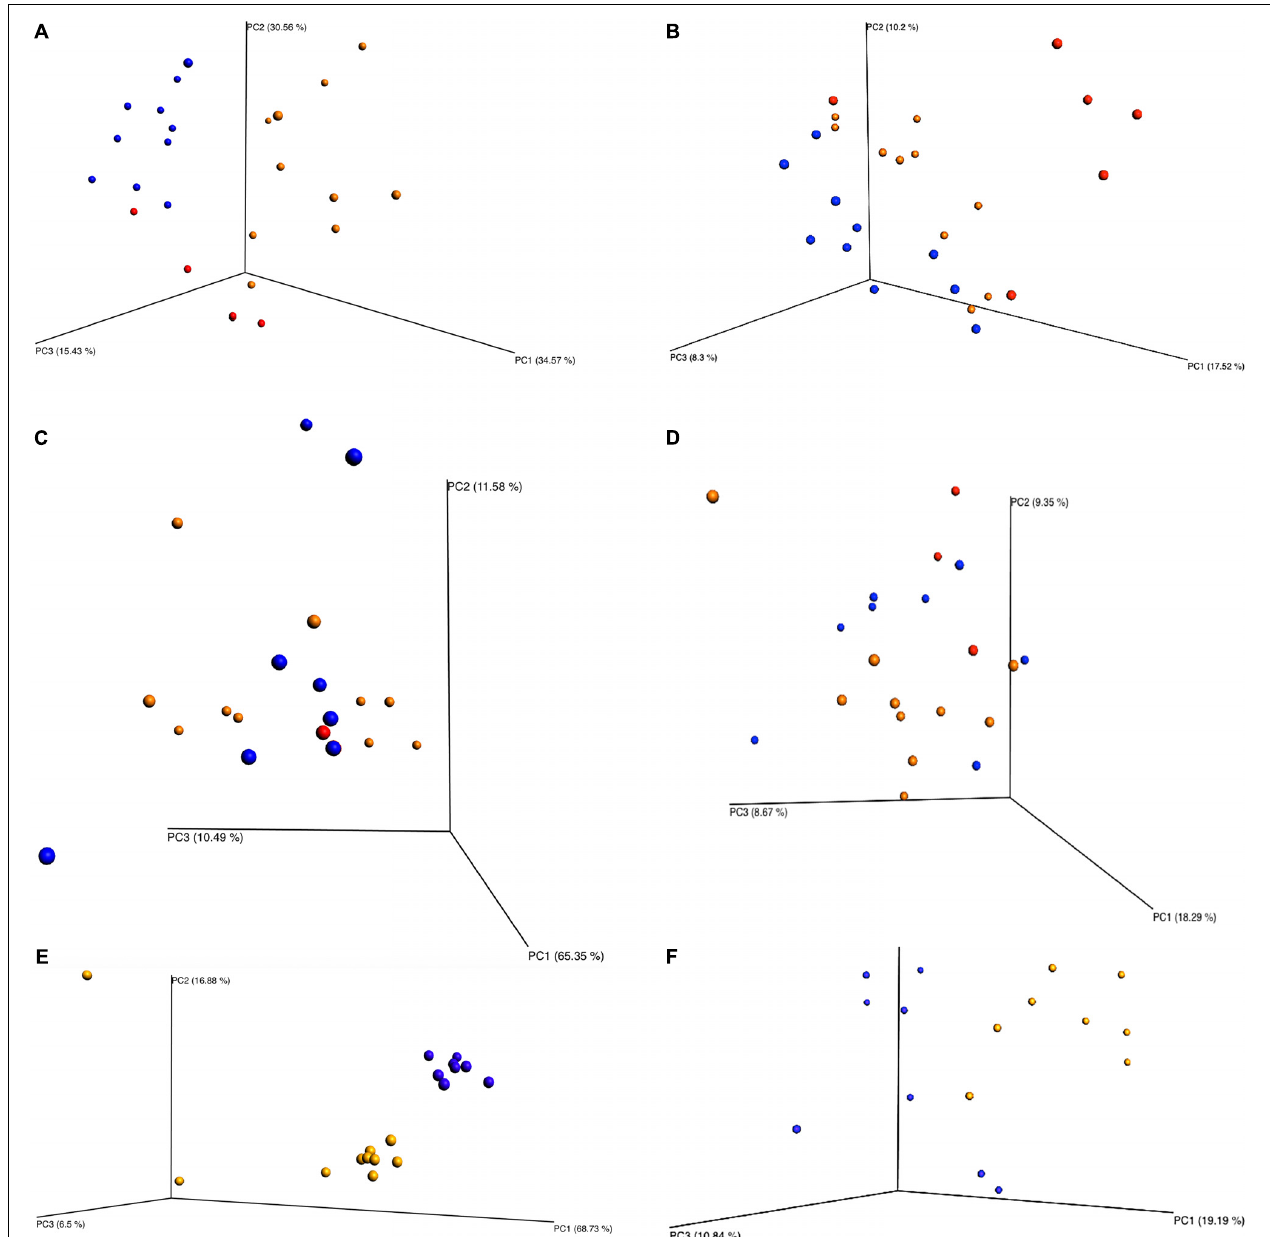
FIGURE 7 | Beta diversity between sampling locations and individual processing abattoir. Weighted and unweighted UniFrac PCoA plots (A) Plant 1 weighted. (B) Plant 1 unweighted. (C) Plant 2 weighted. (D) Plant 2 unweighted. (E) Plant 3 weighted. (F) Plant 3 unweighted. Orange is for rehang, blue is for pre-chill, and red is for